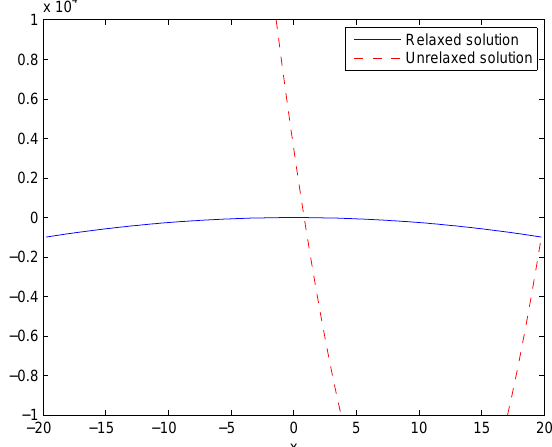
Figure 1: Relaxed and unrelaxed Lyapunov function stability criteria for Example 1, for states originating in region 1 and staying in re- gion 1. The unrelaxed Lyapunov function (cid:0) ¯ (cid:1) ¯ P ¯ A ¯ P is given by ¯ x T A T ¯ x (the LHS 1 1 − 1 1 of (26)), while the relaxed Lyapunov func- (cid:0) ¯ (cid:1) ¯ P ¯ A ¯ P A T ¯ x (the LHS tion is ¯ x T 1 1 − 1 + G 11 1 of (30)). The criteria are here evaluated for ¯ x = [ x 1] T . The unrelaxed solution holds for the required region x > 3 . 487, while the relaxed solution holds